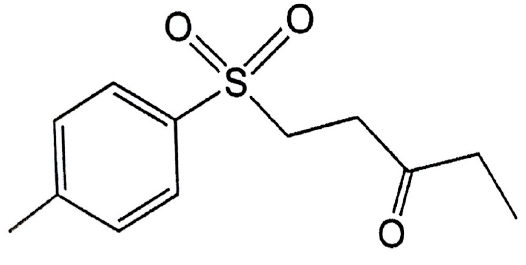
Figure 1. Chemical structure of 1-tosylpentan-3-one (1T3O).